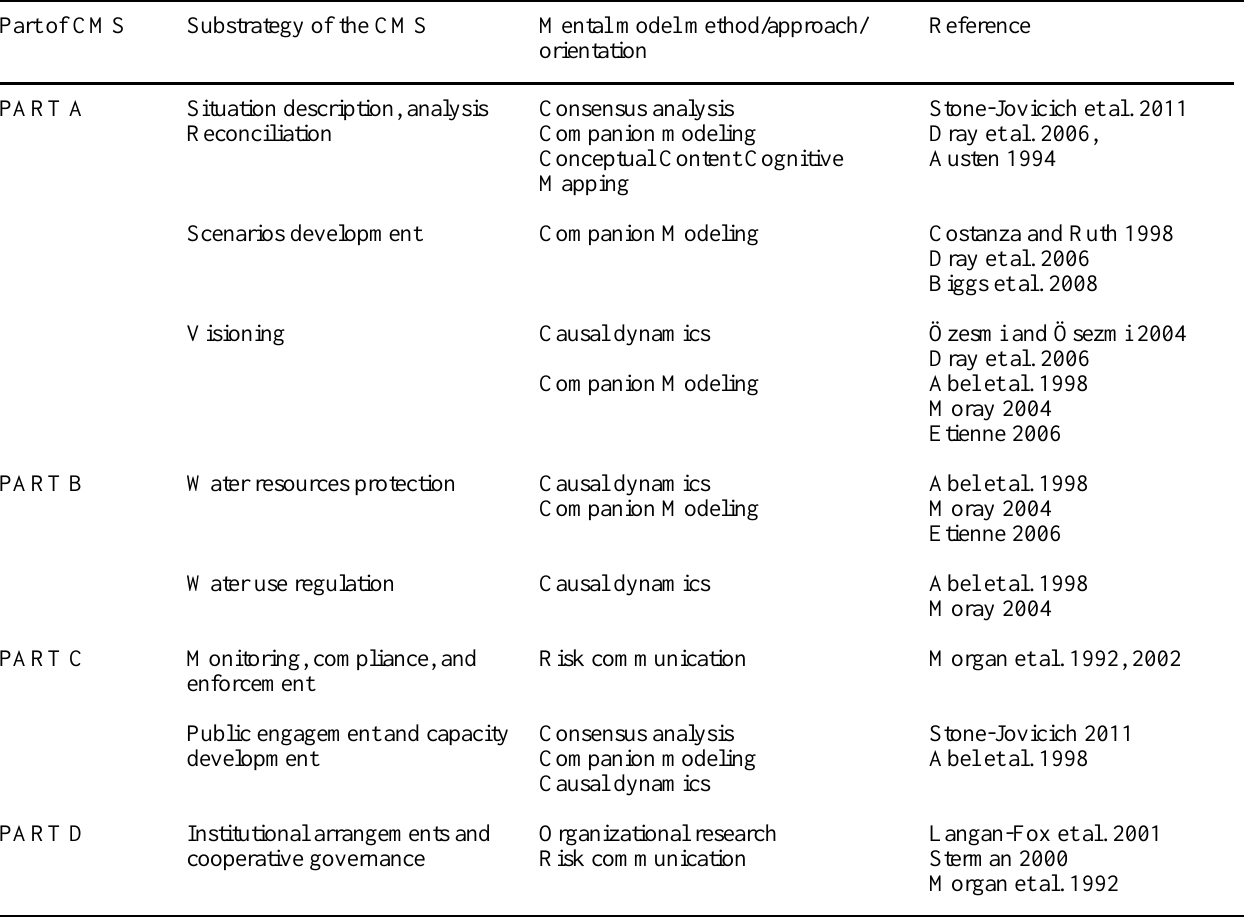
Table 1. Potential match between the Catchment Management Strategy (CMS) planning process and mental model